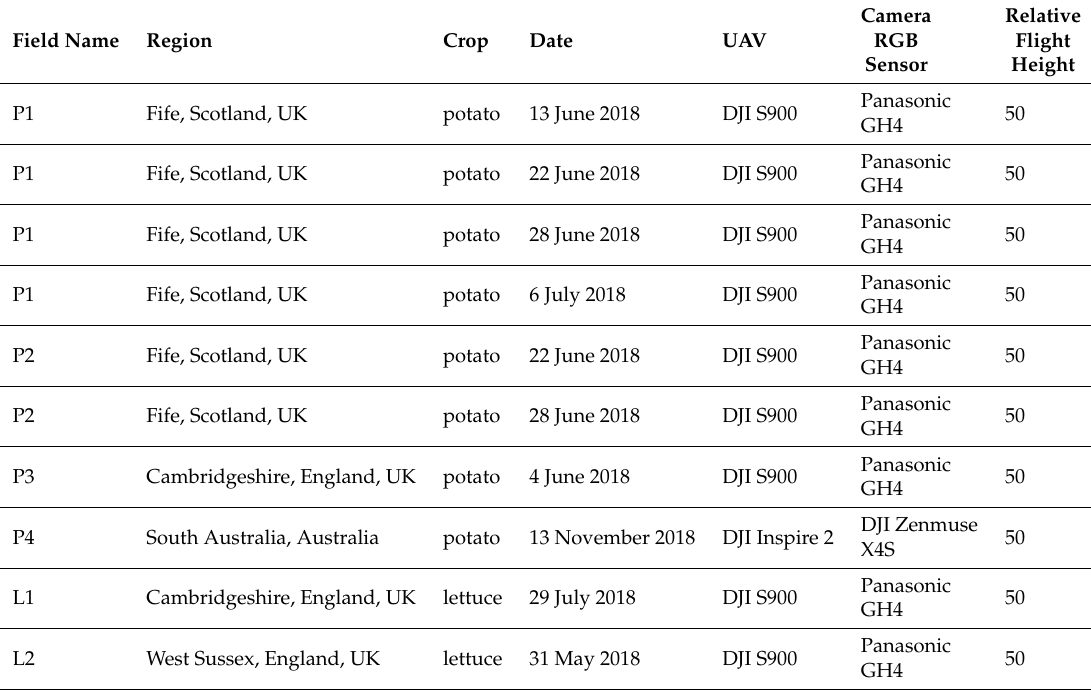
Table 1. Characteristics of flight acquisition of imagery in the study area.